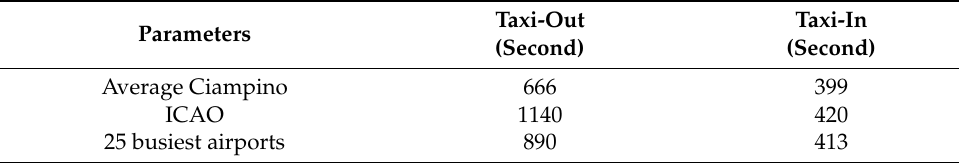
Table 6. Taxi-out and taxi-in phases duration in the 2019 emission